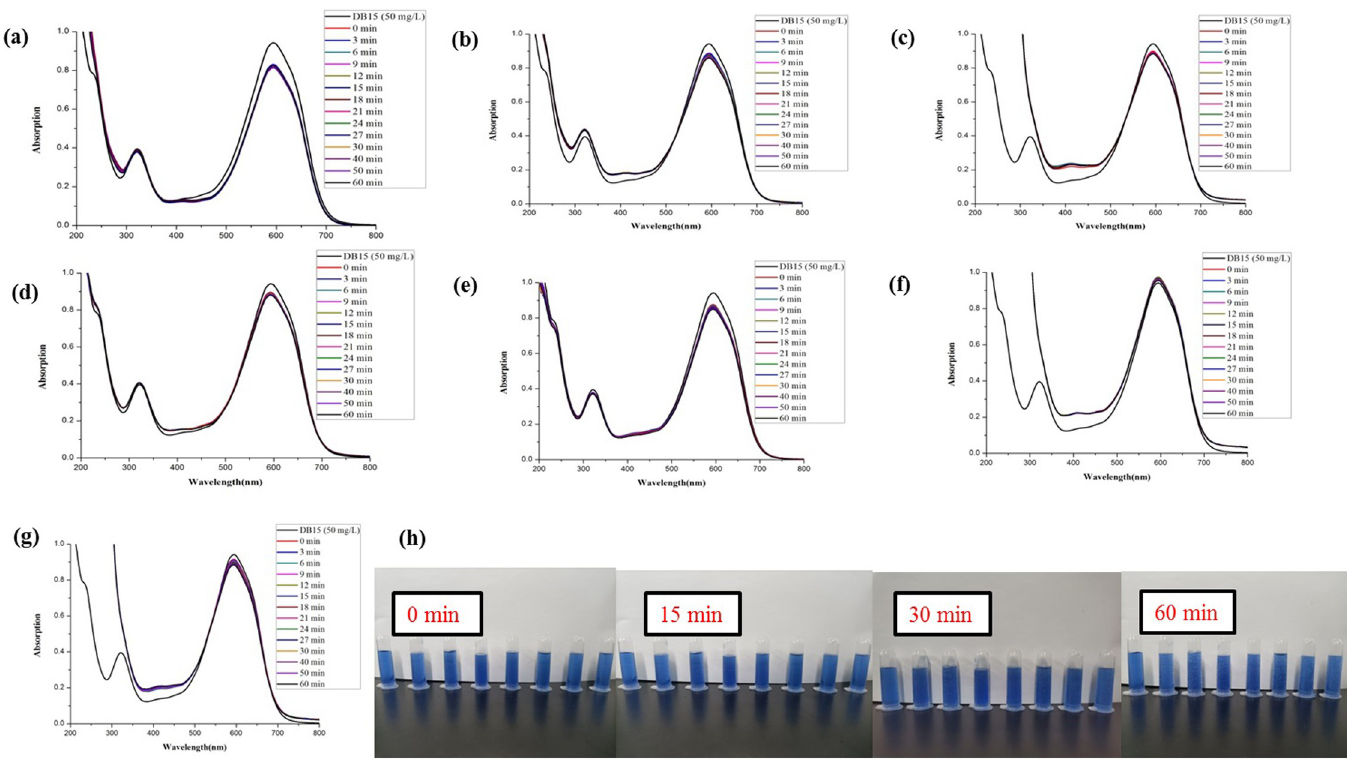
Fig 8. Comparison of the reductive degradation of Direct Blue 15 using different dry ginger extracts: (a) unpeeled dry ginger water extract; (b) peeled dry ginger water extract; (c) dry ginger peel water extract; (d) unpeeled dry ginger ethanol extract; (e) peeled dry ginger ethanol extract; (f) dry ginger peel ethanol extract; (g) CK; (h) The solution appearance comparison of mixtures different dry ginger extract and DB15 after reaction for 0, 15, 30 and 60 min. The solutions from left to right are DB15 (50 mg/L), CK, unpeeled dry ginger water extract, peeled dry ginger water extract, dry ginger peel water extract, unpeeled dry ginger ethanol extract, peeled dry ginger ethanol extract, and dry ginger peel ethanol